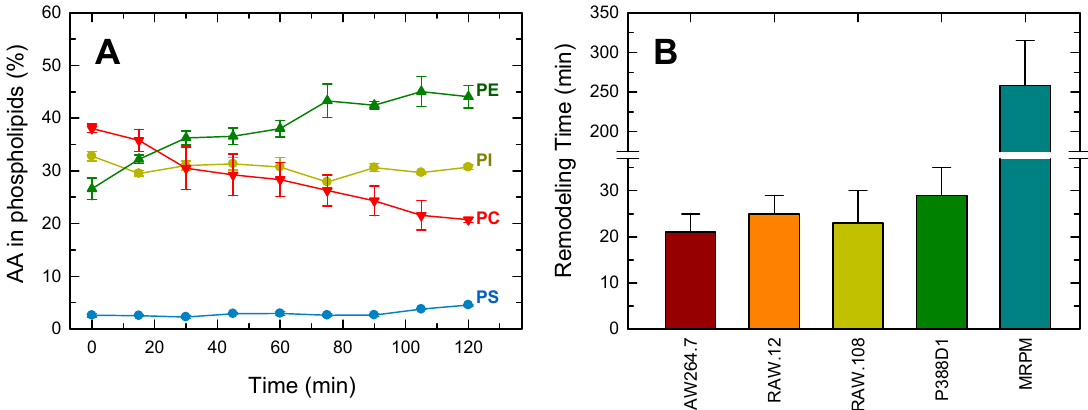
Figure 3. Phospholipid AA remodeling in RAW 264.7 cells and plasmalogen-deficient variants: ( A ) RAW 264.7 cells were pulse-labeled with [ 3 H]AA, washed, and incubated without label for the indicated periods of time. Phospholipids were separated into classes by thin-layer chromatography. The radioactivity incorporated into each phospholipid class was determined by scintillation counting and is given as a percentage of the radioactivity present in phospholipids. ( B ) AA remodeling was analyzed for different cell types, and the remodeling time (time at which the radioactivity content of PC equals that of PE) was determined. Results are shown as means ± S.E.M. (n = 6 for panel A; n = 3 for panel B). MRPM, mouse resident peritoneal macrophages.